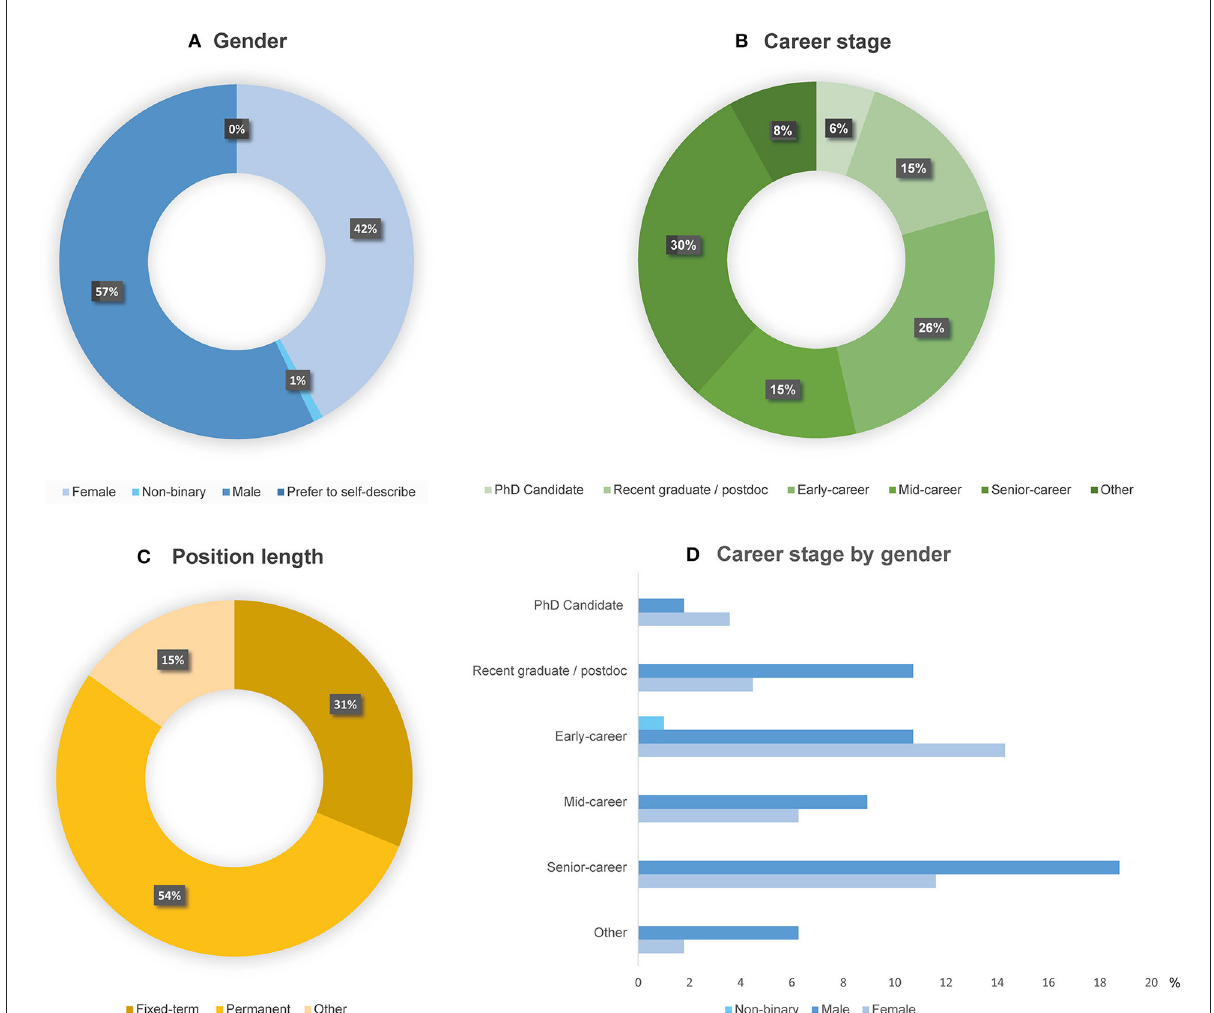
FIGURE3 Socio-demographic variables of survey respondents; (A) Gender, (B) Career stage, (C) Position type, (D) Career stage by